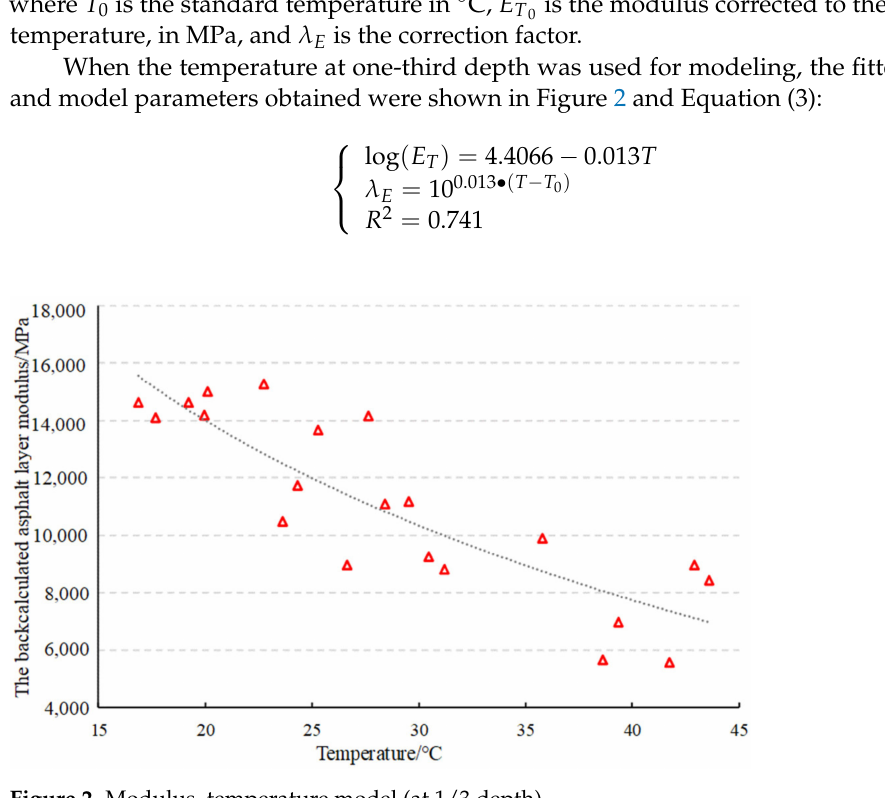
Figure 2. Modulus–temperature model (at 1/3